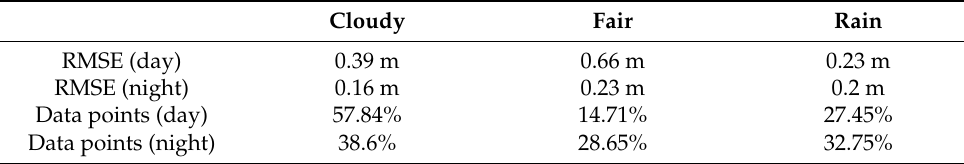
Table 1. Collective RMSE error under all weather